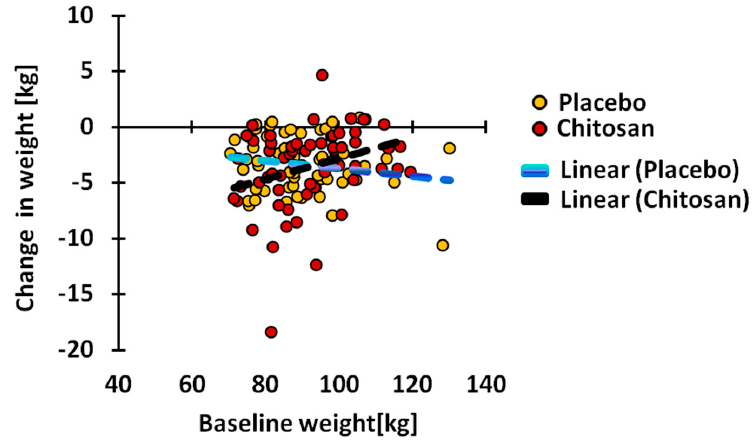
Figure 1. Dependence of the change in weight on baseline weight values under chitosan and placebo treatments. Under chitosan treatment, the change was significantly ( p = 0.0083) and positively associated with baseline values.